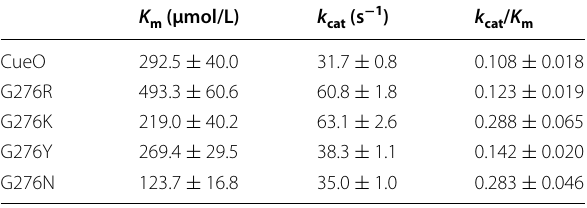
Table 1 Catalytic parameters of wild-type CueO and mutants